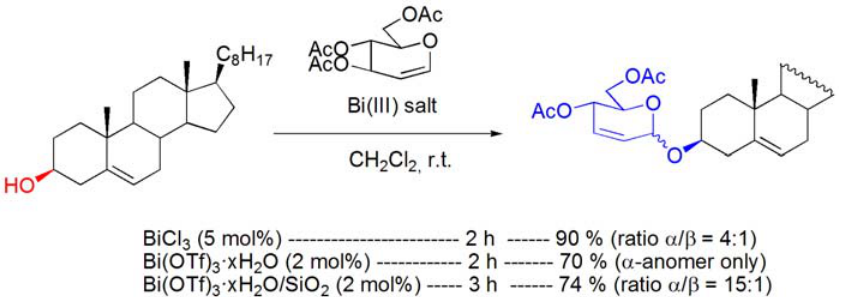
Scheme 23. Bismuth(III) salt-catalyzed Ferrier